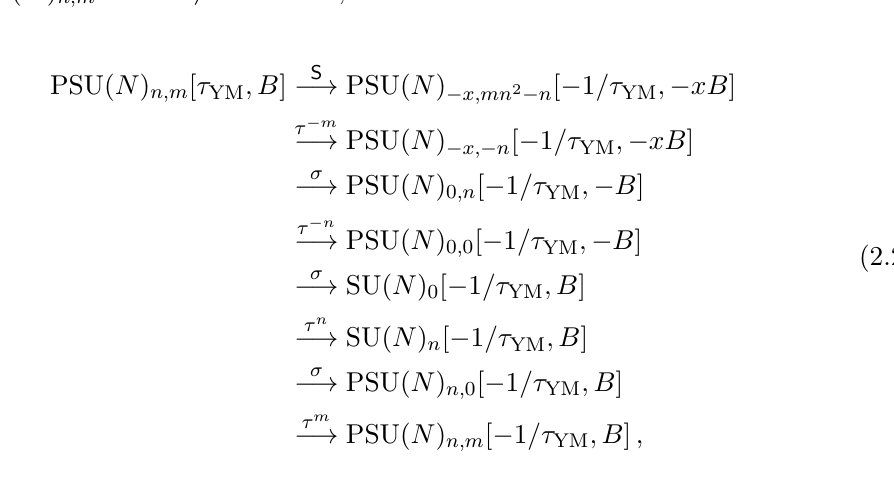
For PSU( N ) with n 6 = 0 mod N , we n,m